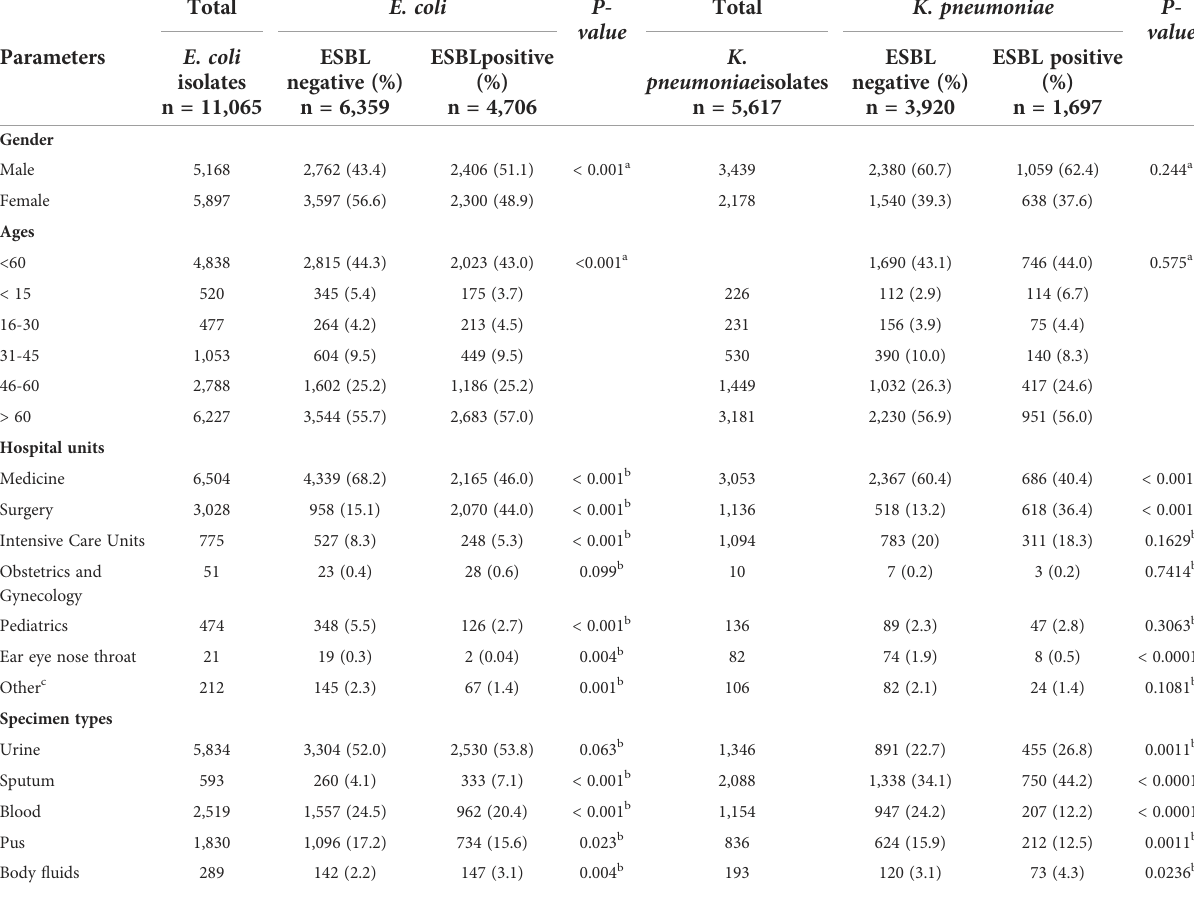
TABLE 2 Clinical characteristics of patients infected with ESBL-producing and non-ESBL-producing E. coli and K. pneumoniae isolates. Total E.